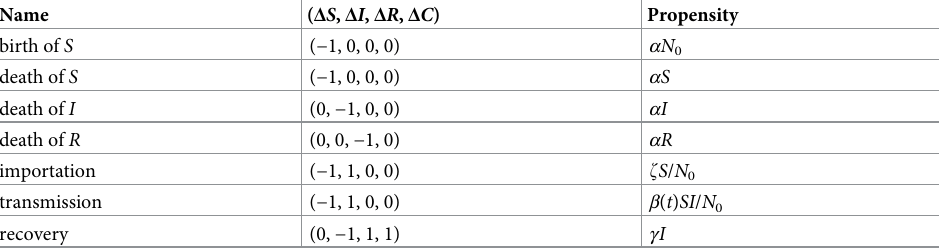
Table 2. Transitions of the SIR process model. At the beginning of each aggregation period C is reset to